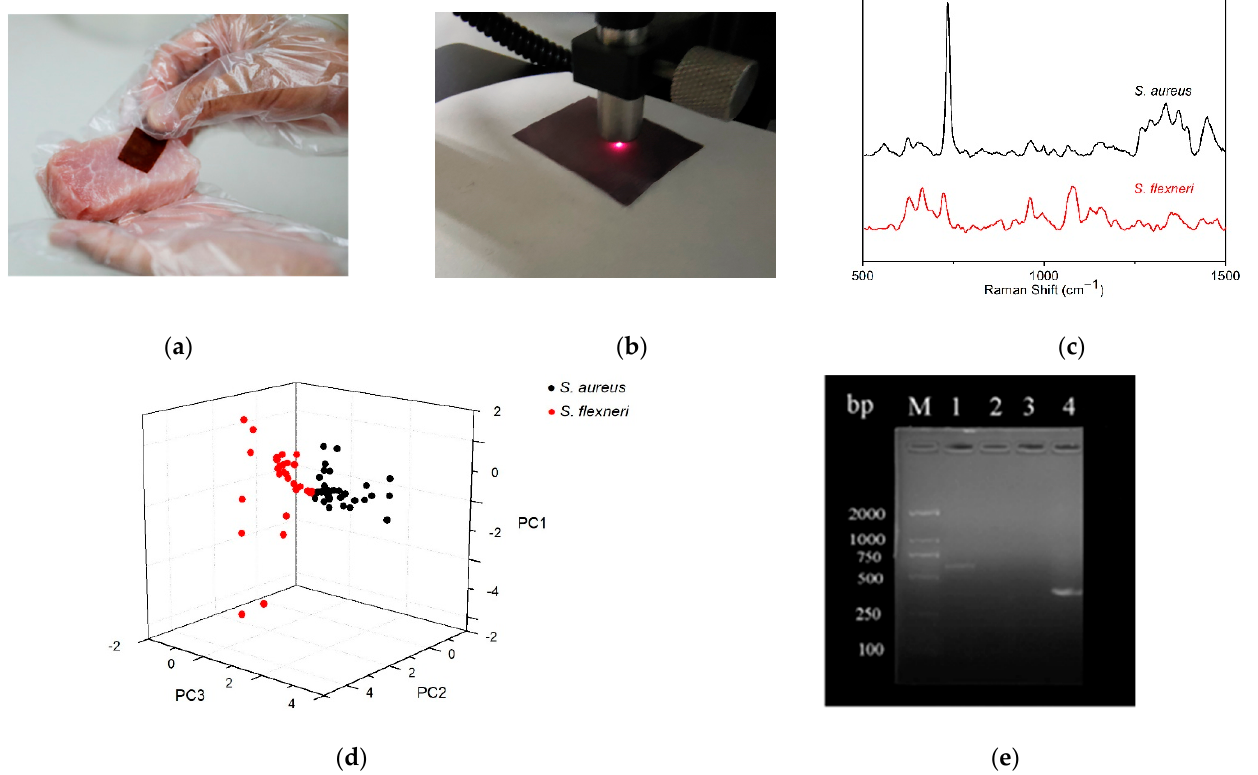
Figure 6. The detection of two pathogens based on the flexible SERS platform and PCR. ( a ) Sample collection process on spiked pork; ( b ) detection process with the portable Raman spectrometer; ( c ) SERS spectra of S. flexneri and S. aureus obtained from the Au-TPP substrates; ( d ) three-dimensional scatter plot of PC scores of S. aureus and S. flexneri ; ( e ) PCR amplified nuc and ipaH gene expression. Note: M: PCR marker DL2000; 1: S. aureus nuc gene expression; 2: S. aureus ipaH gene expression; 3: S. flexneri nuc gene expression; 4: S. flexneri ipaH gene expression. Table 1. PC-LDA classification results of S. aureus and S. flexneri. Prediction Group Sample